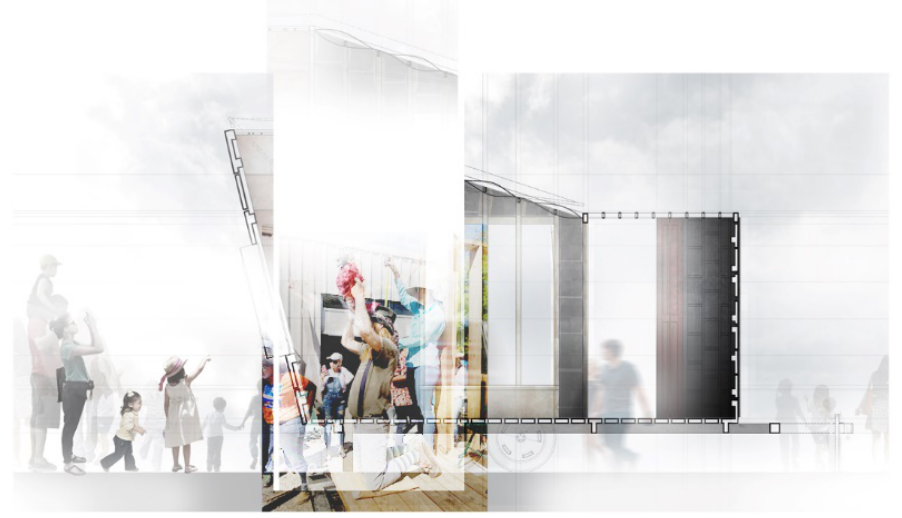
Figure 9. Performance Collage by Lisa Ryzhikova (McIntosh and Ryzhikova 2018).